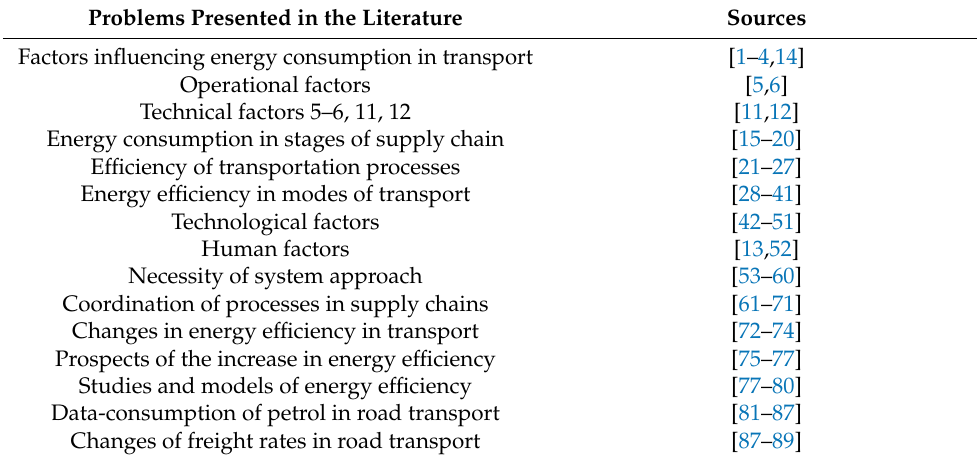
Table 1. Literature sources used in the